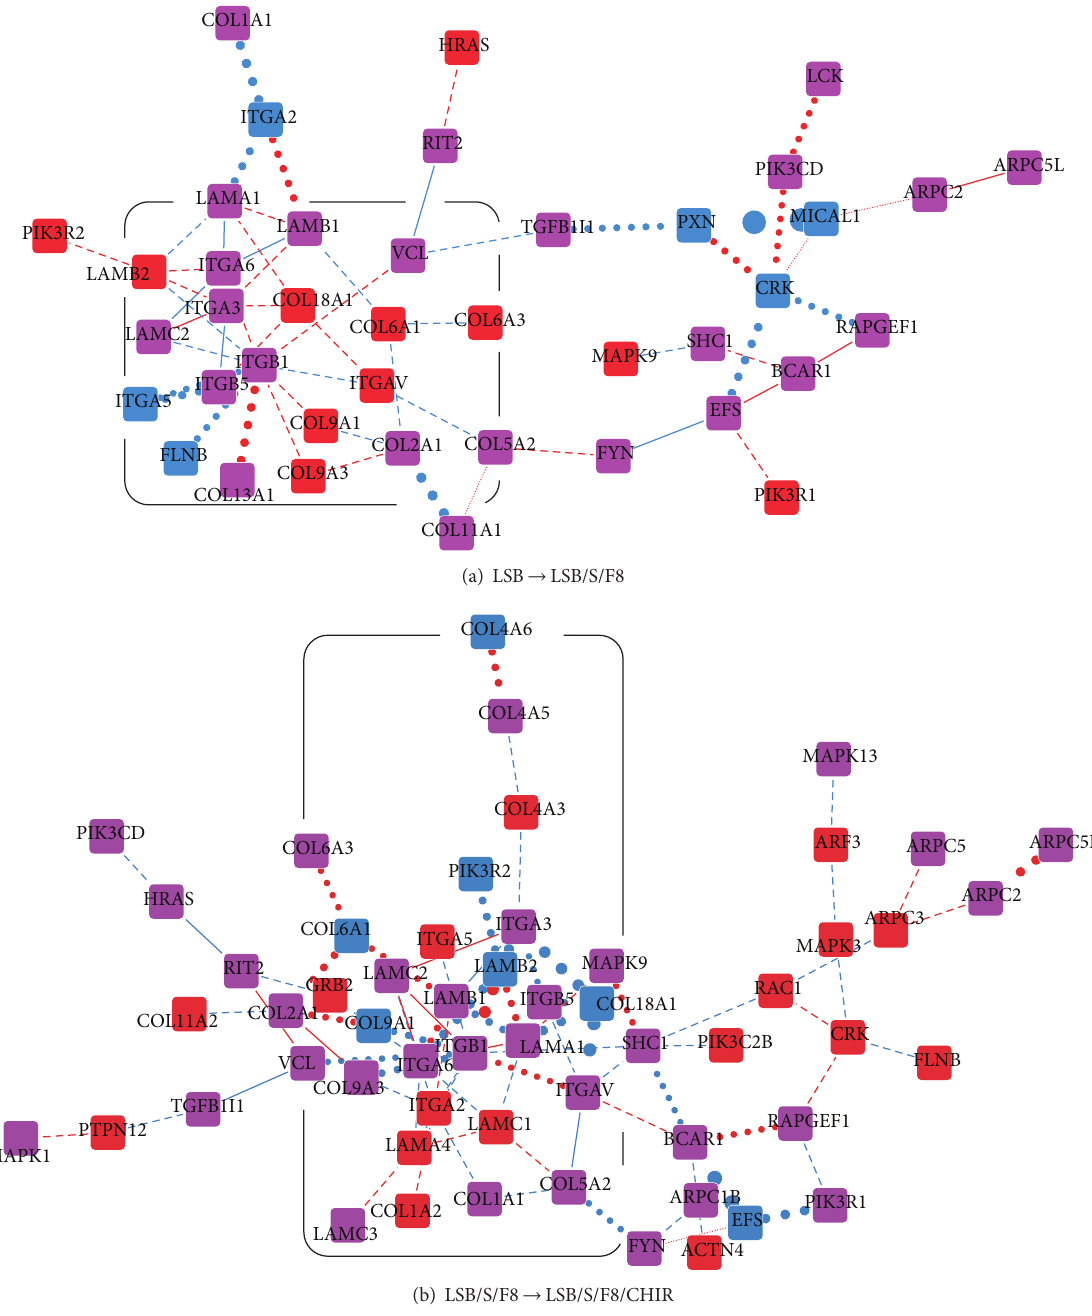
Figure 4: The interaction activity variations of the integrin functional module in the directed differentiation process at two differentiation stage transitions. (a) Interaction activity variations from the LSB stage to the LSB/S/F8 stage. (b) Interaction activity variations from the LSB/S/F8 stage to the LSB/S/F8/CHIR stage. Node and edge colors and edge line styles have the same interpretation as in Figure 2. The rounded squares are the core subnetworks in the integrin functional